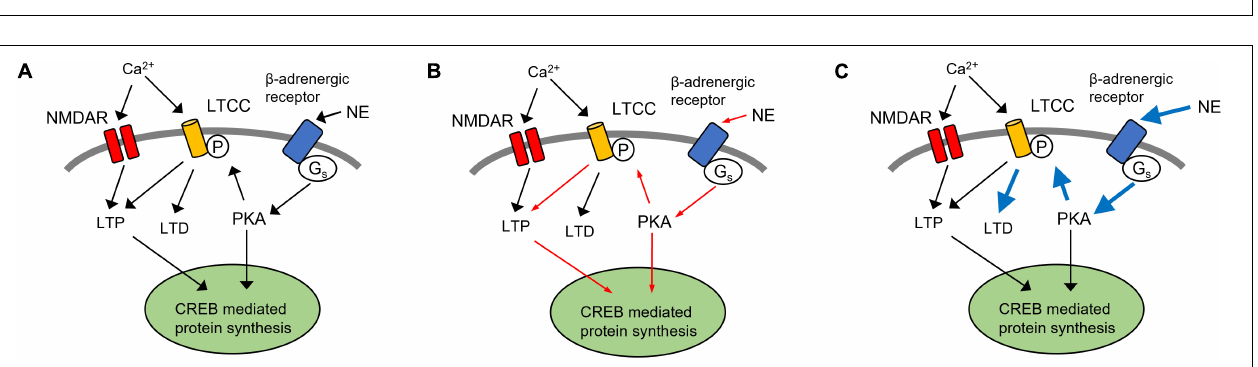
FIGURE 2 | discrimination deficiency (D1,D2) , or LC cell loss (D3) , or LC fiber degeneration (D4) in young 6 month-old rats infused with htauE14 at 2–3 month-old. (E1–E4) Impairment in similar (SOD), but not dissimilar odor discrimination (DOD) learning in 10 month-old rats infused with htauE14 at 2–3 month-old (E1,E2) , no LC cell loss (E3) but LC fiber degeneration in the piriform cortex (PC) was observed (E4) . (F1–F3) Deficiency in SOD (F1) , LC cell number loss (F2) and fiber degeneration (F3) in 17–20 month-old rats infused with, htauE14 at 12–14 month-old. (G1,G2) LC fiber density in the PC is correlated with olfactory discrimination learning performance. NET, norepinephrine transport; DBH, dopamine beta-hydroxylase; HT7, Human Tau 7. Scale bars, 50 µ m. Adapted and modified from Ghosh et al. (2019) and Omoluabi et al. (2021).